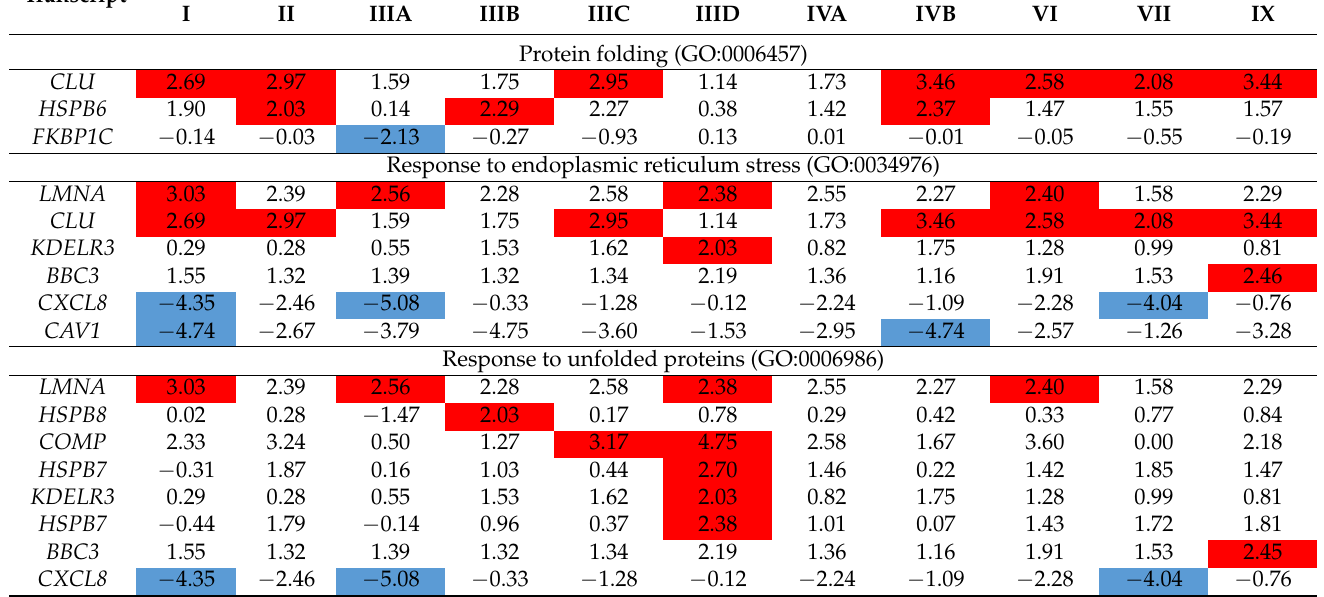
Table 4. Genes included into ‘protein folding’ (GO:0007165), ‘response to endoplasmic reticulum stress’ (GO:0034976), and ‘response to unfolded protein’ (GO:0006986) terms of Gene Ontology with expression significantly changed (at FDR < 0.1; p < 0.1 in one-way ANOVA and post hoc Student’s t -test with Bonferroni correction) and with particularly high values of the fold change (log 2 FC > 2 or < − 2) in specific MPS types relative to control cells (HDFa). Down-regulated and up-regulated genes are marked in blue and red, respectively. Non-marked values indicate results in which no statistically significant differences between MPS and HDFa were